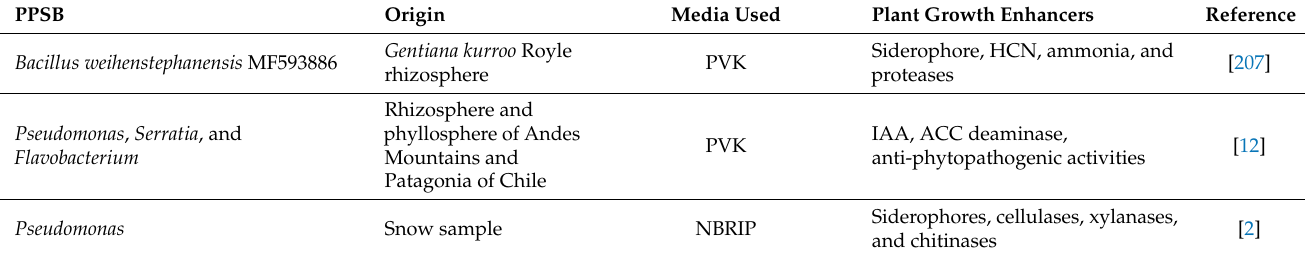
Figure 1. Cold active phosphate biofertilizers: isolation, characterization, P solubilization, and plant growth promotion in the low-temperature environment. Table 3. Plant growth-promoting active biomolecules released by psychrophilic/psychrotolerant phosphate solubilizing